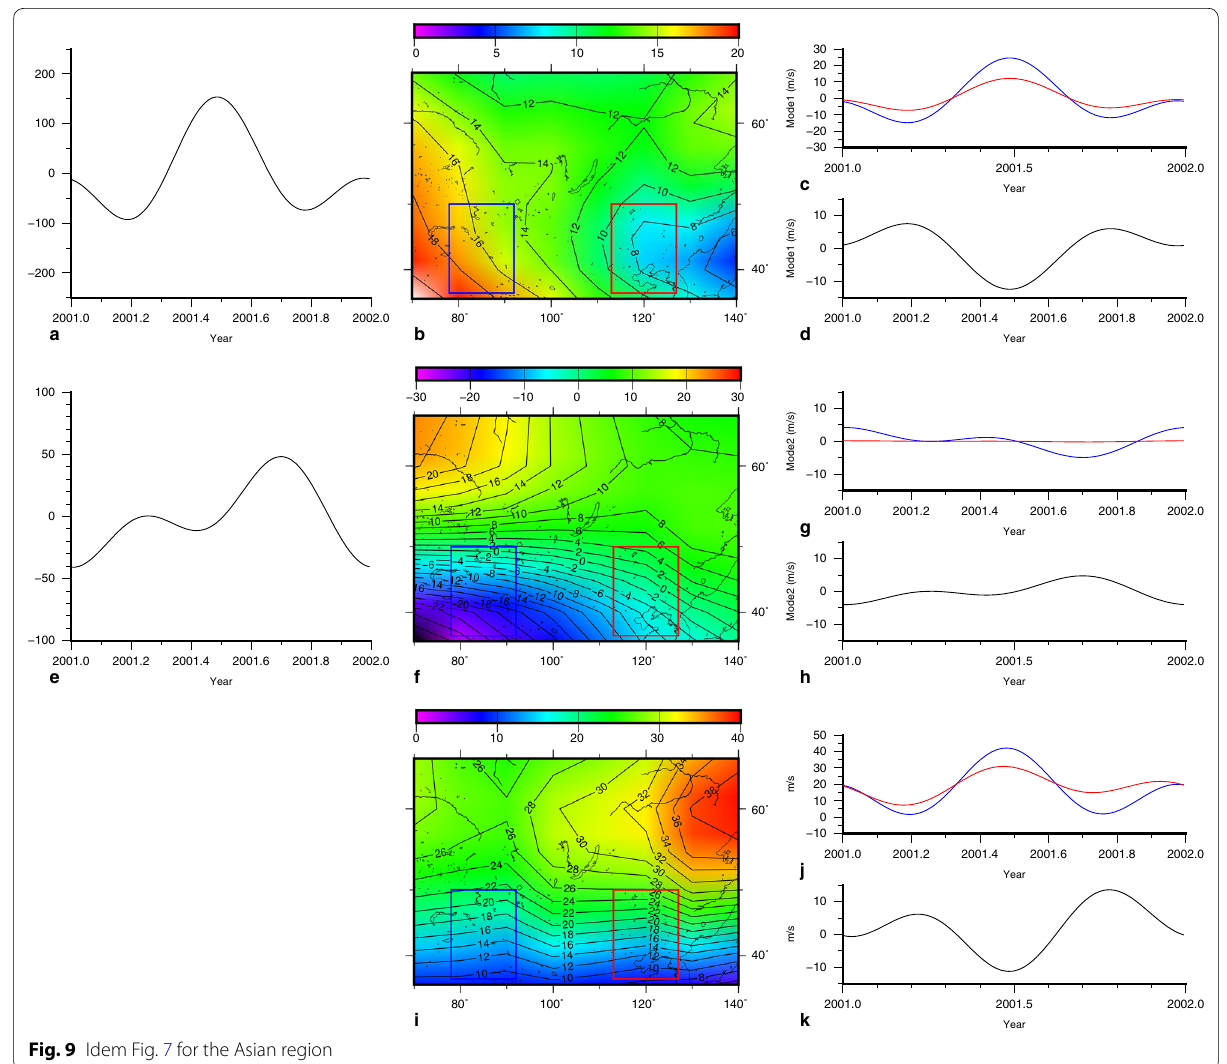
Fig. 9 Idem Fig. 7 for the Asian